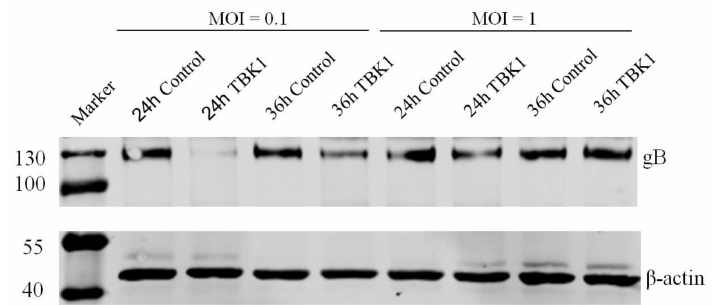
Figure 4. Overexpression of TBK1 decreased gB protein expression during DEV infection. DEF cells were transfected with pCAGGS-TBK1 and infected with DEV at a MOI of 0.1 or 1 for 24 h, 36 h by western blot analysis. Expression of gB protein in the TBK1 overexpressed group compared with the control group were analyzed by western blot assays, with β -actin protein as the